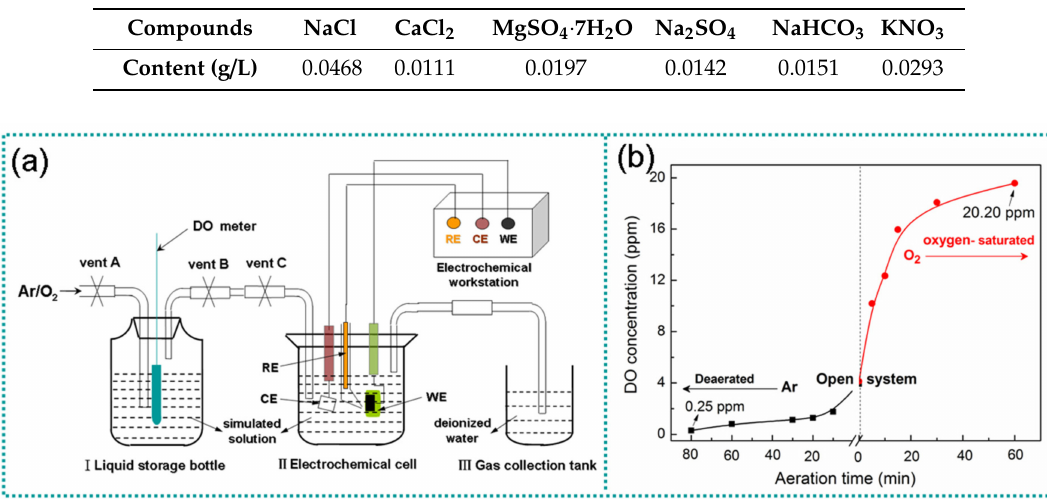
Table 1. Chemical composition of the acidic soil (Yingtan soil) simulated solution [24–26].